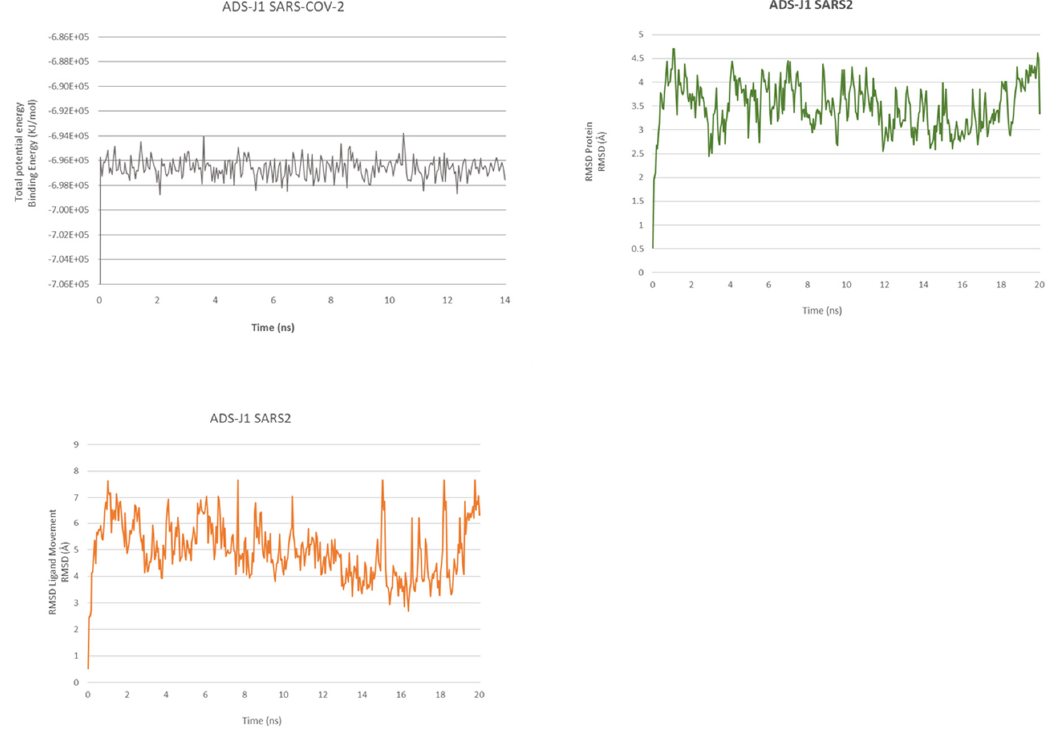
Figure 2. ADS-J1@SARS-CoV-2 fusion core. Total energy ( upper left ), RMSDs ( upper right ) of protein and RMSDs ligand ( lower left ).